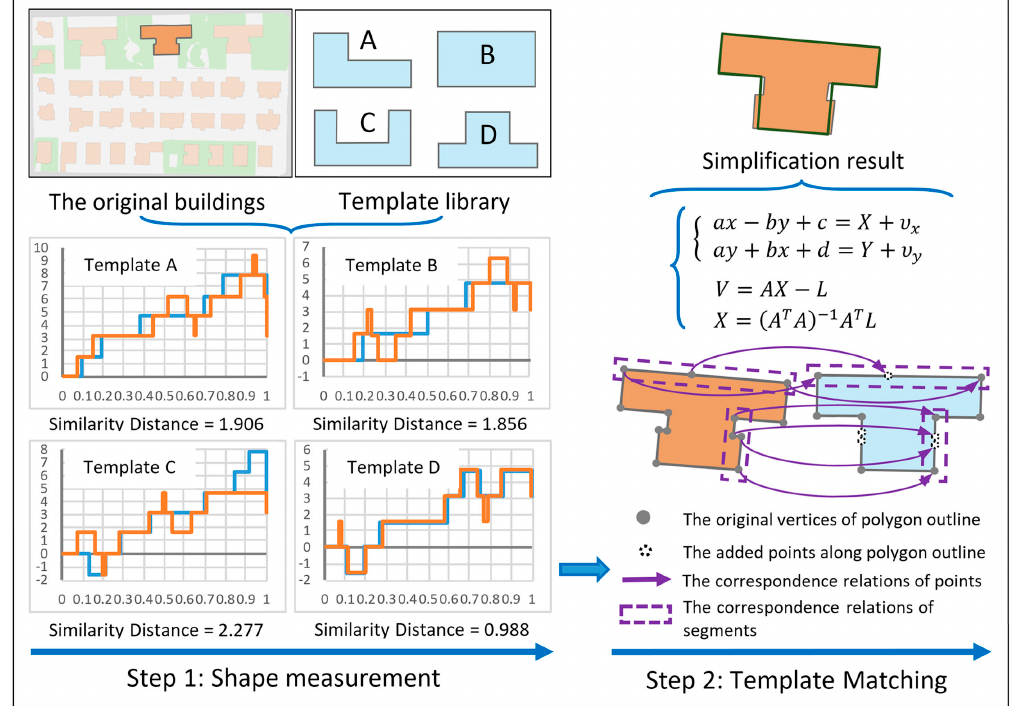
Figure 2. The procedure of building simplification using the template matching method.